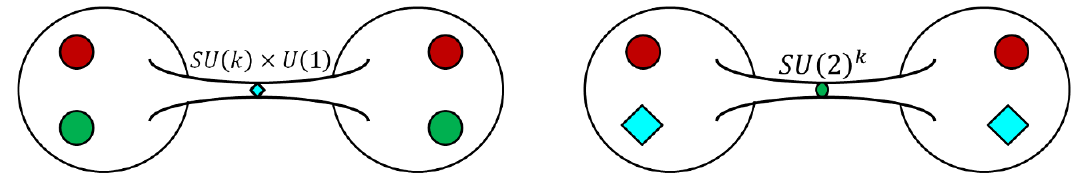
Figure 22 . Two types of four punctured spheres. If the suggestion is correct the corresponding models should enjoy dualities exchanging same types of